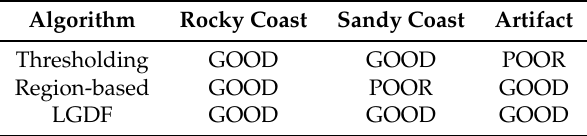
Table 3. Performances of different segmentation algorithms on the selected test site.